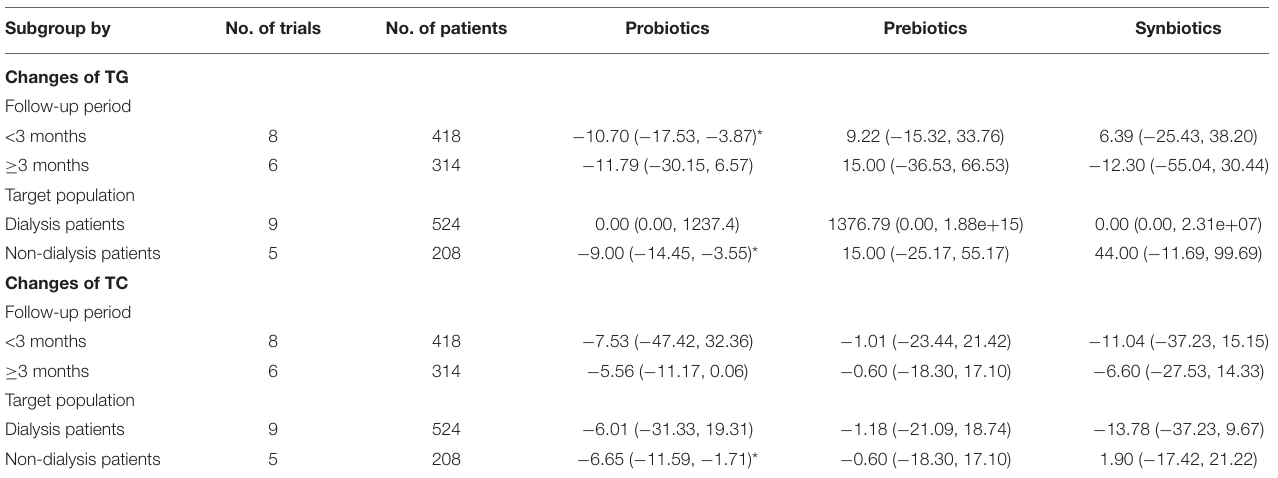
TABLE 3 | Subgroup analysis of lipid